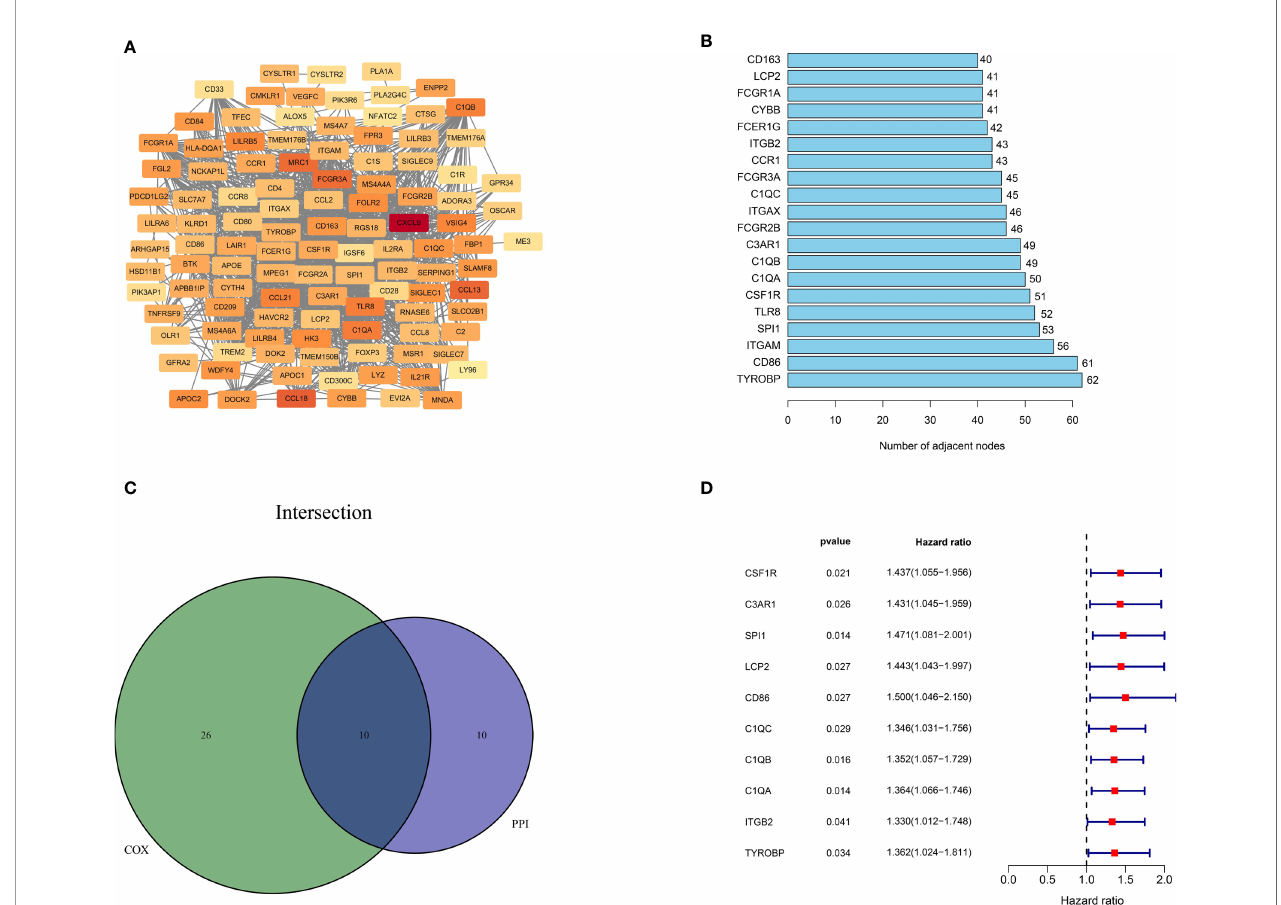
FIGURE 4 | Protein-protein interaction network and univariate COX analysis. (A) PPI network constructed with the nodes with interaction con fi dence value > 0.4. (B) The top 20 genes according to the number of nodes. (C) Venn plot for 10 hub prognostic DEGs. (D) The 10 hub prognostic genes with p < 0.005 in univariate COX regression